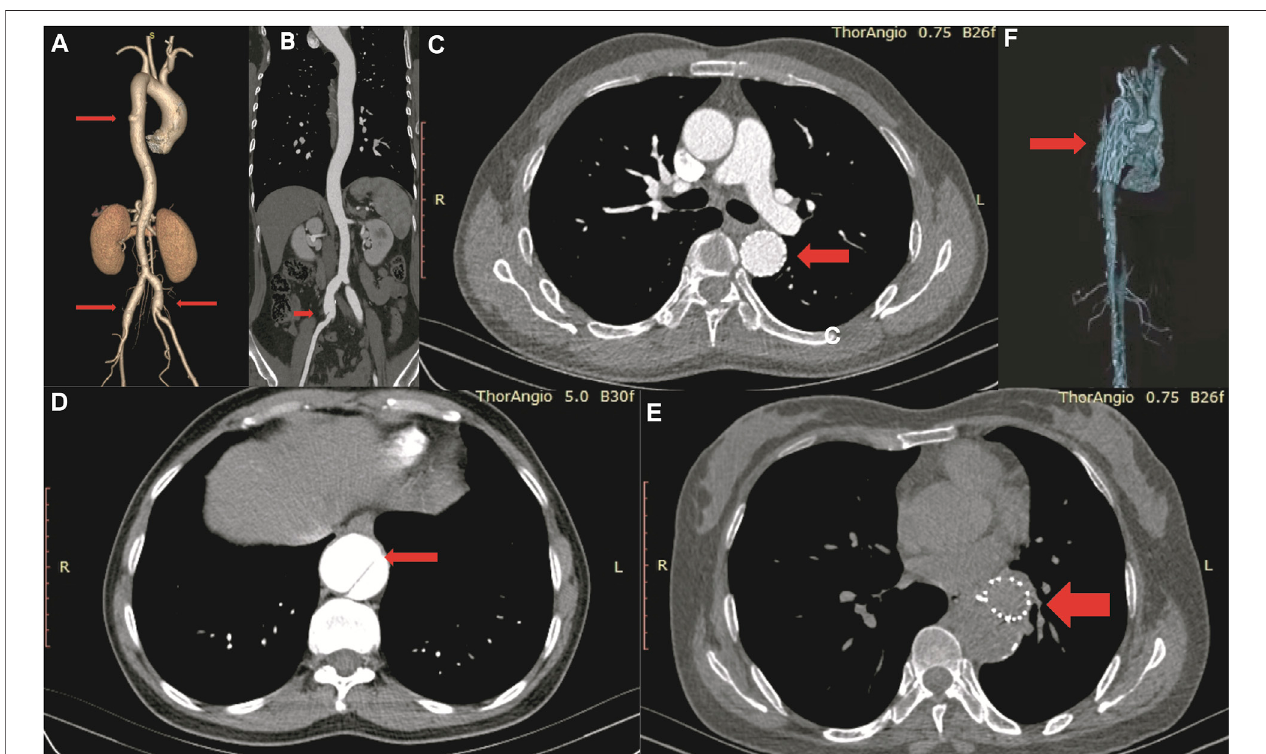
FIGURE 3 | CT angiography image of III-4 in TAAD-1 (A, B) , II-3 in TAAD-2 (C – E) and II-3 in TAAD-3 (F) .